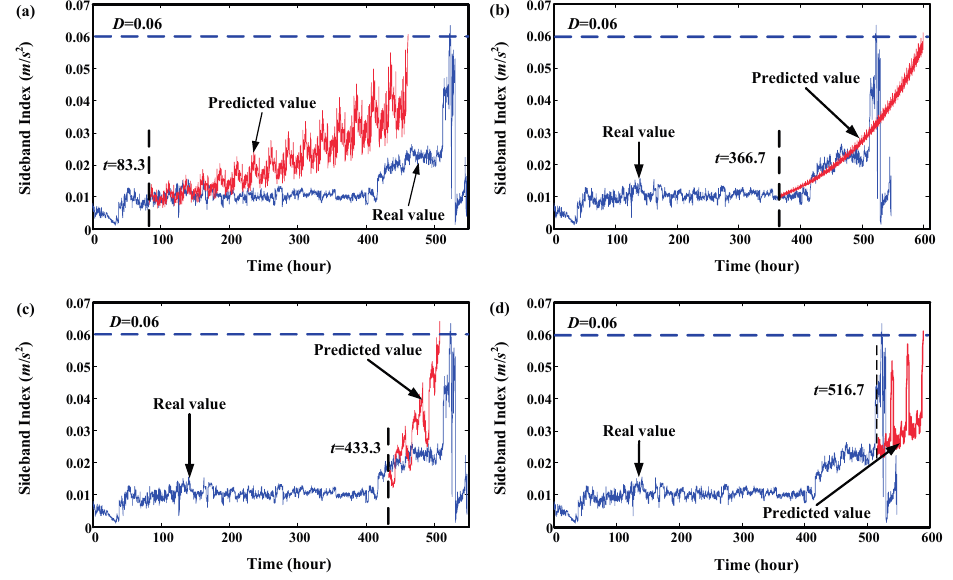
Figure 17. Trend prediction results of degradation data of gearbox. ( a ) prediction results at start time 83.3 h; ( b ) prediction results at start time 366.7 h; ( c ) prediction results at start time 433.3 h; ( d ) prediction results at start time 516.7